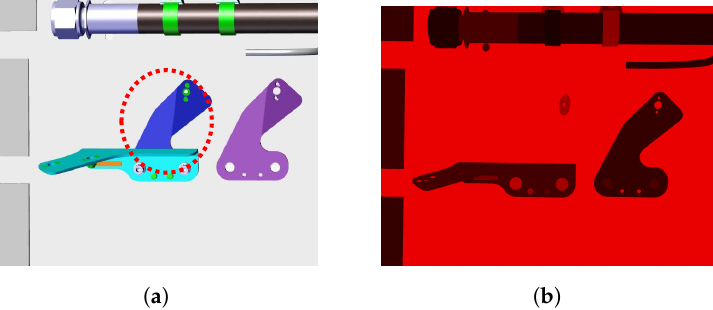
Figure 10. ( a ) Example of CAD model; ( b ) context image of the blue